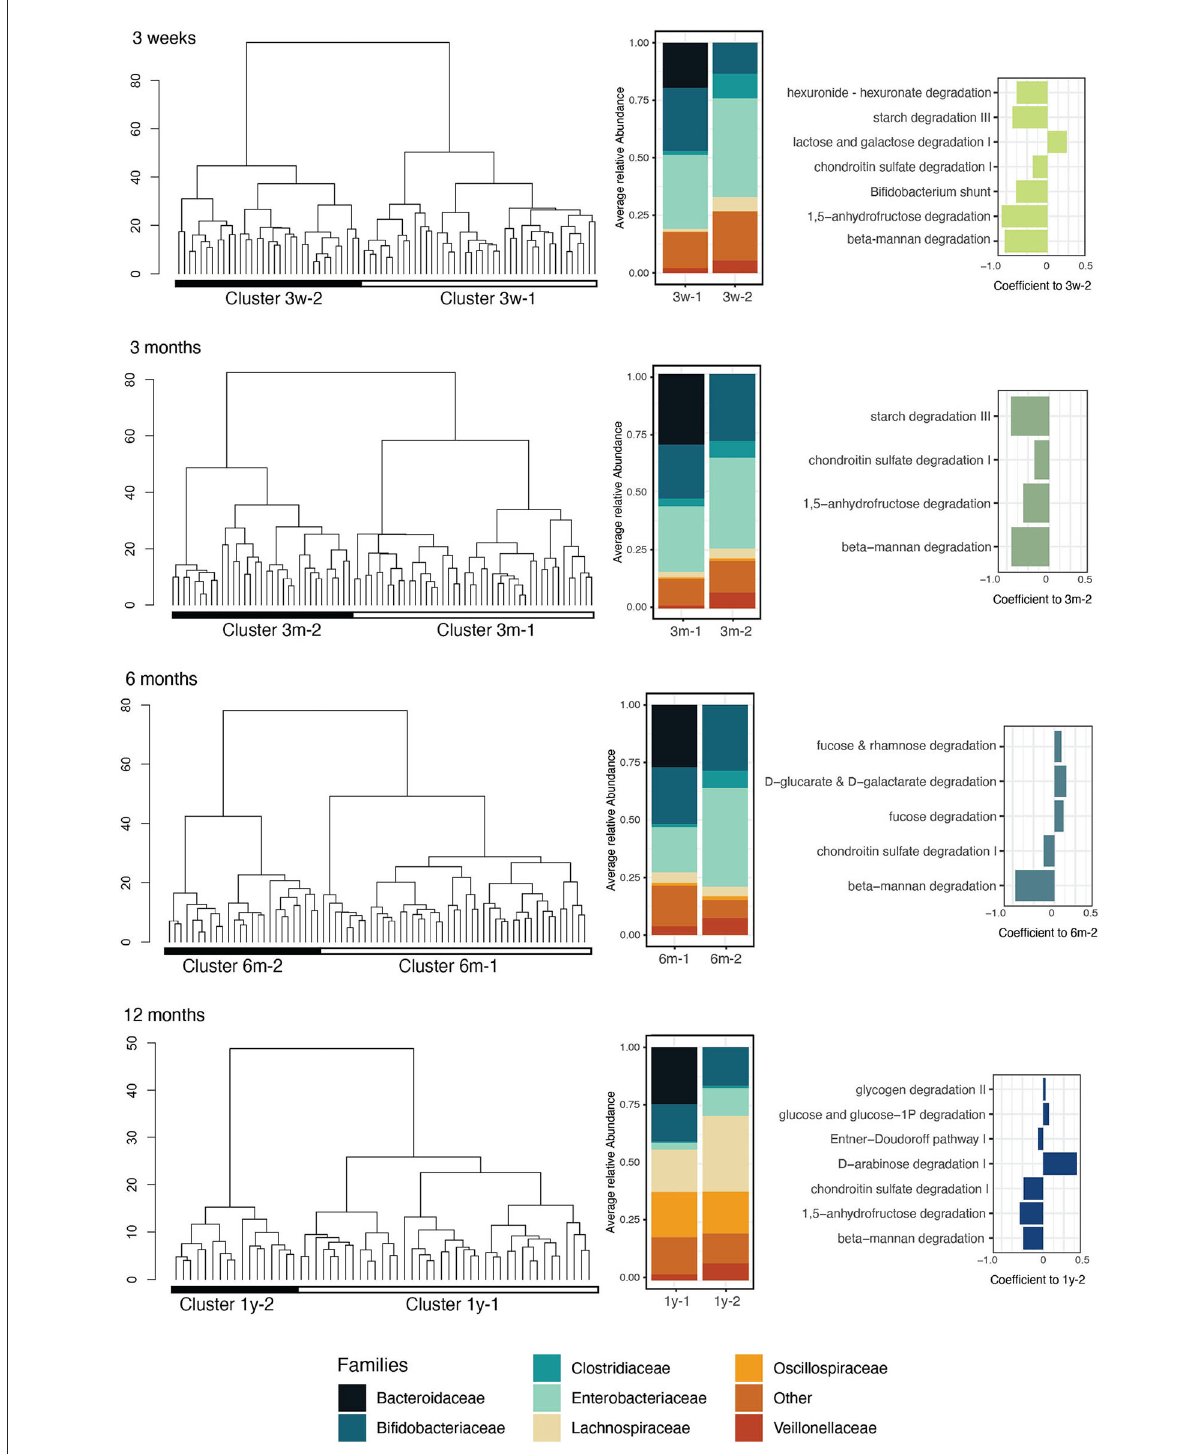
FIGURE2 Infant gut microbiota clusters, representative bacterial families, and enriched functions related to carbohydrate metabolism. At each sampling time point (3 weeks, 3 months, 6 months, and 1 year), the infants’ samples were clustered by hierarchical clustering on taxonomic profiles aggregated at the family level using the Aitchison distance (Column 1). The color blocks below the dendrograms represent the clusters identified using the silhouette maximization method (Column 2). The average relative abundance of the families in each cluster was represented in the associated bar plots. Families with detection and prevalence below 10% were grouped into the “Other” category (Column 3). Bar plot showing the coefficients of differentially abundant carbohydrate metabolism-related pathways (MaAsLin2, linear model, q < 0.1) in the two identified clusters. Negative coefficients indicate association to cluster